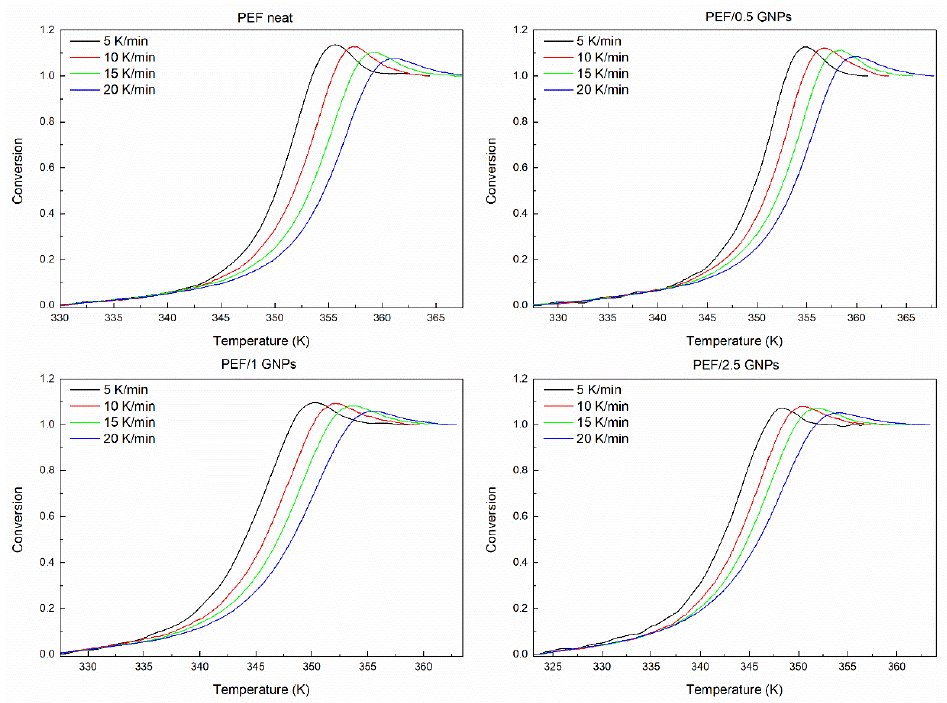
Figure 8. Conversion curves of the glass transition area of all the prepared materials.